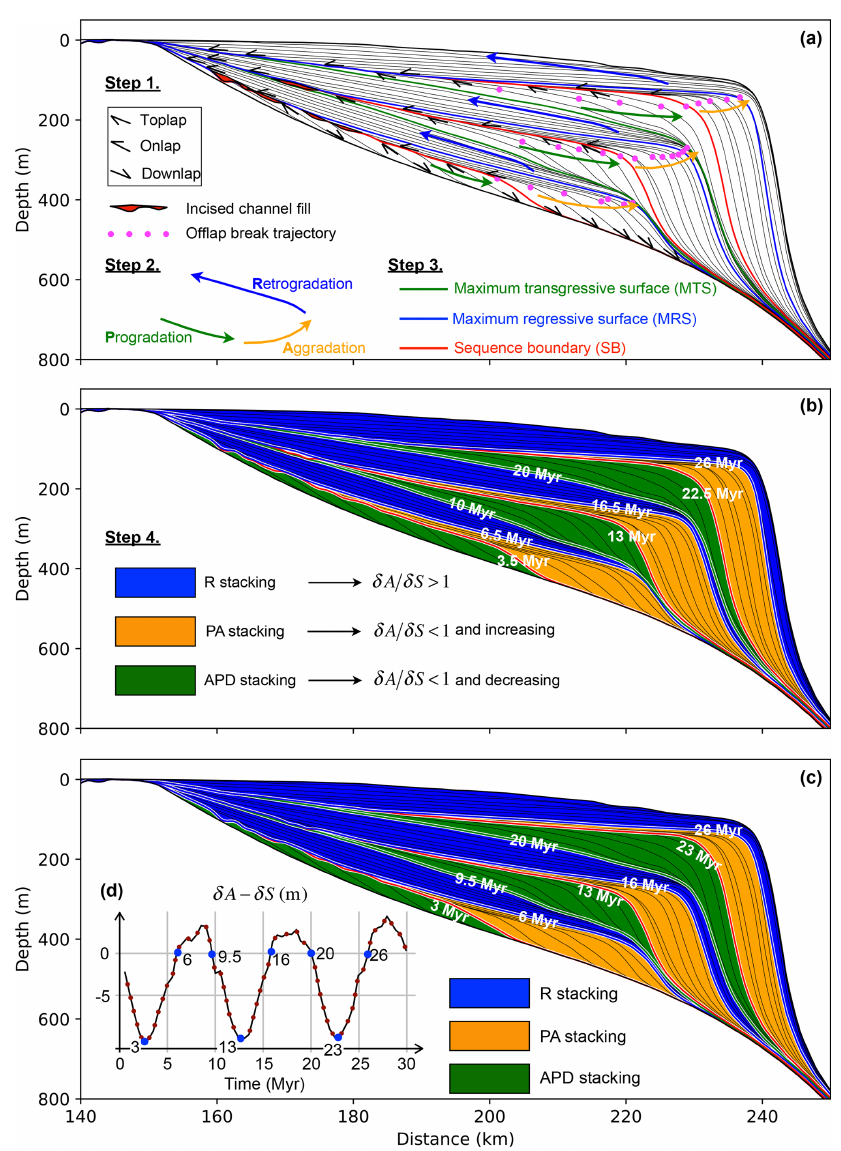
Figure 8. (a–b) Interpretation workflow based on the accommodation succession method (Neal et al., 2016). Step 1 includes marking stratal terminations (i.e. toplap, onlap and downlap represented using small arrows) and manually picking the break in slope as offlap break. The refilling of incised channels is shown in red, indicating erosional surfaces. Based on the marked stratal contacts, three stratal stacking trends (solid arrows) and three stratigraphic surfaces (coloured solid lines) are then defined in Steps 2 and 3. The three interpreted stacking patterns are filled with different colours, with their bounding times marked (Step 4). Each stacking pattern reflects the evolving ratio between rate of accommodation creation ( δA ) and rate of sediment supply ( δS ). (c) Automatically defined stacking patterns according to the calculated temporal evolution of δA − δS ( > 0, < 0 and decreasing, or < 0 and increasing) (d)